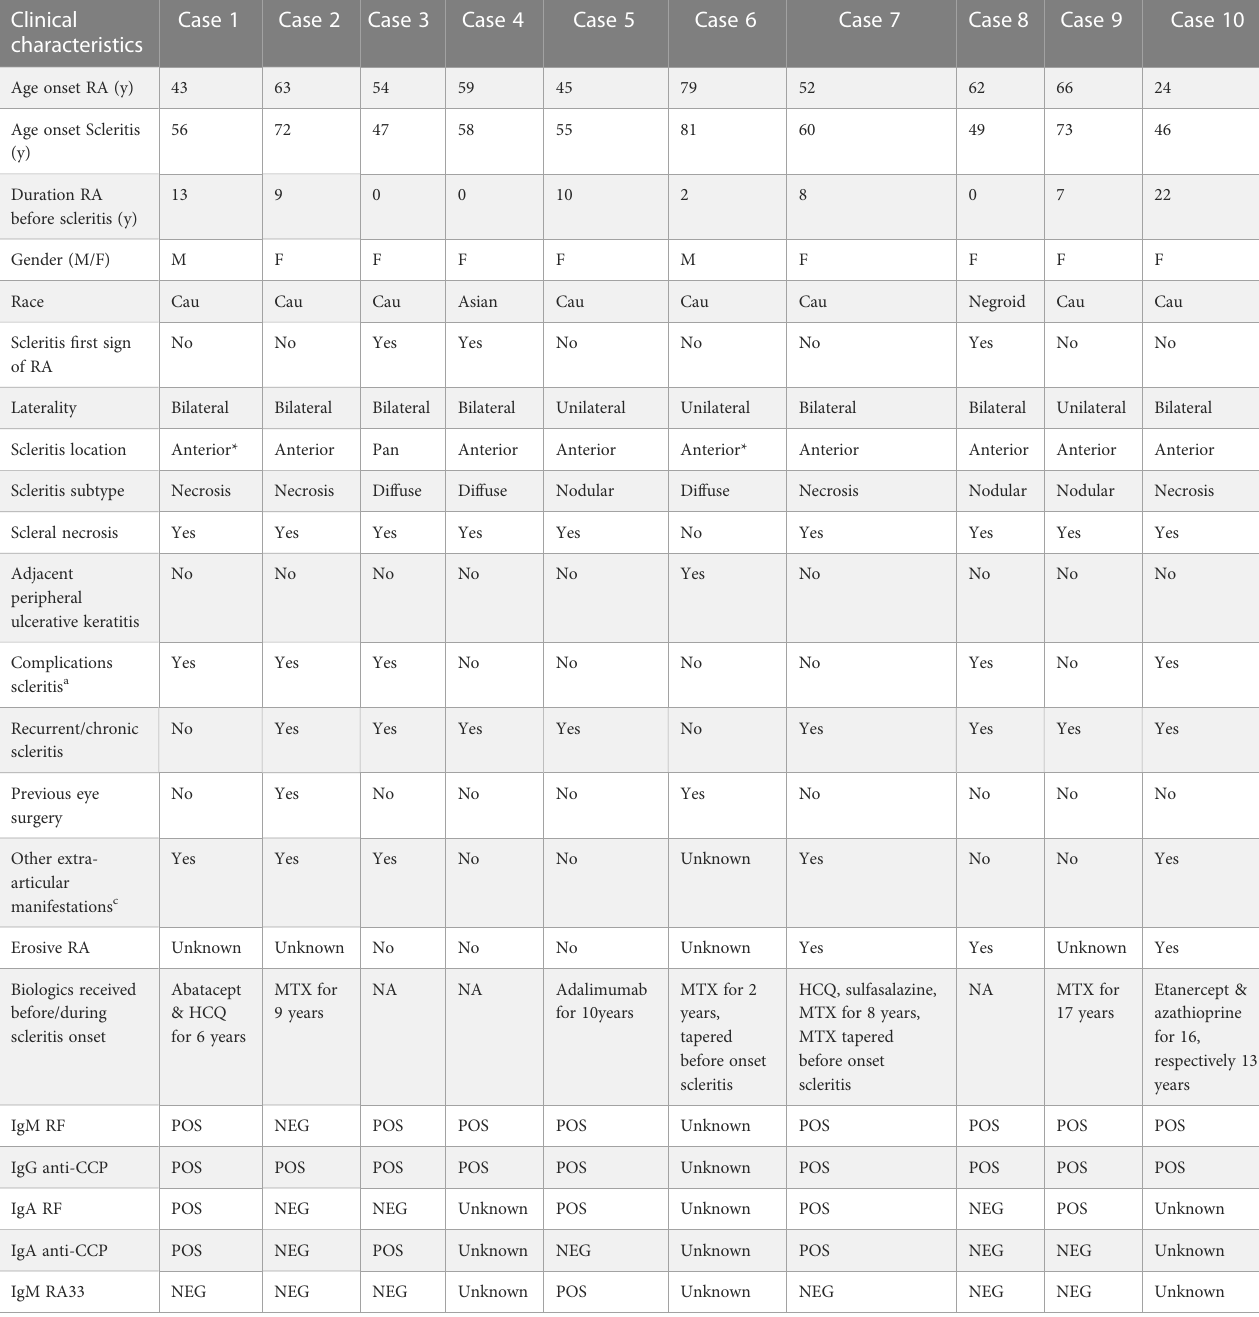
TABLE 3 Characteristics of current 10 patients with rheumatoid arthritis and scleritis. Clinical